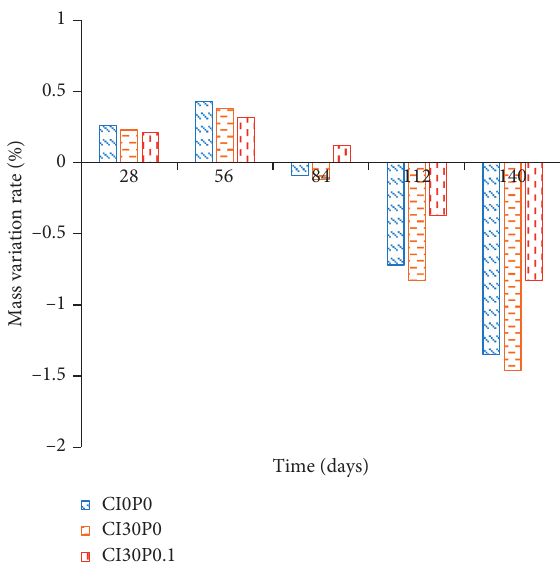
Figure 10: Mass variation rate under drying-wetting cycles in 5% Na